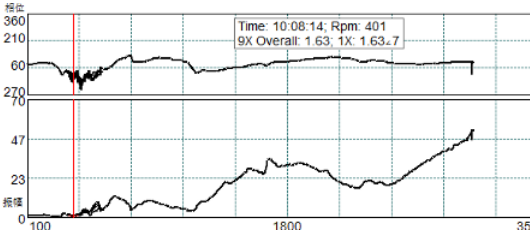
Fig. 3. Bode diagram of 8 watt liter speed.